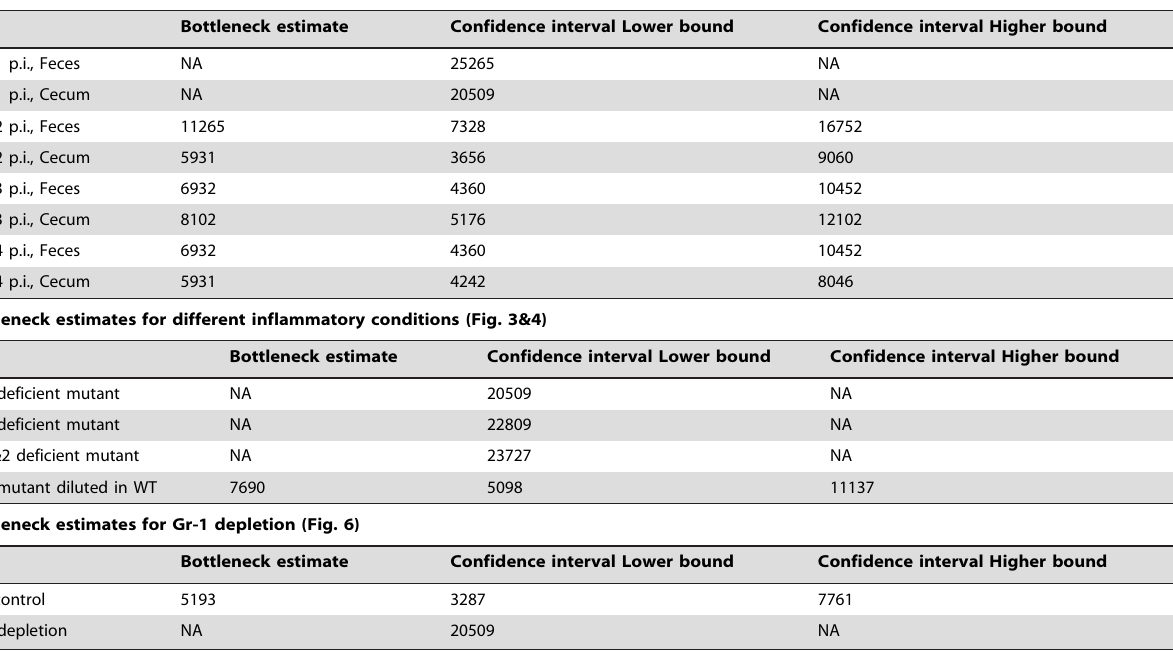
Bottleneck estimates for different lengths of infection (Fig.